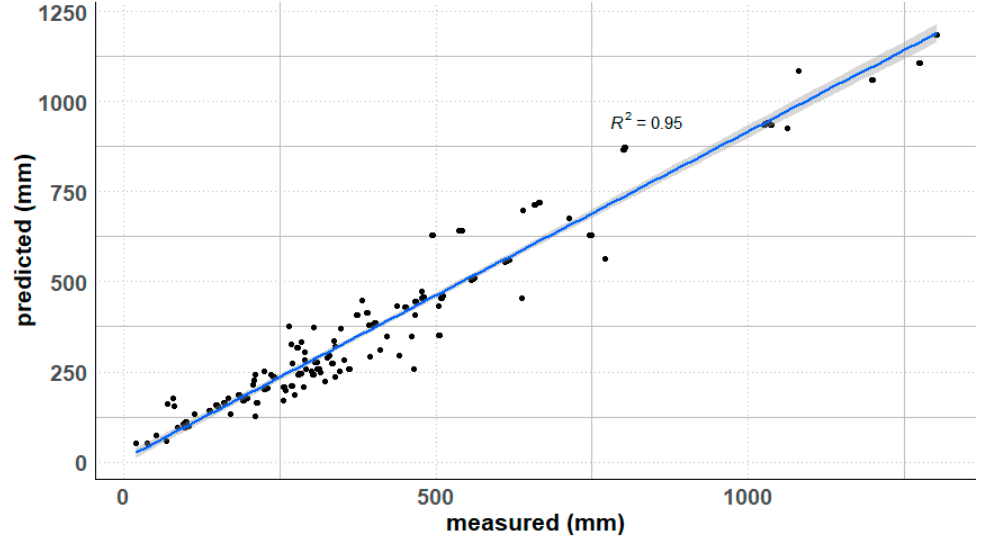
Figure 3. HPTF validation by comparisons of the gauge-measured values with the predicted percolation rate + runoff, taken in 106 catchments areas in Germany [22].